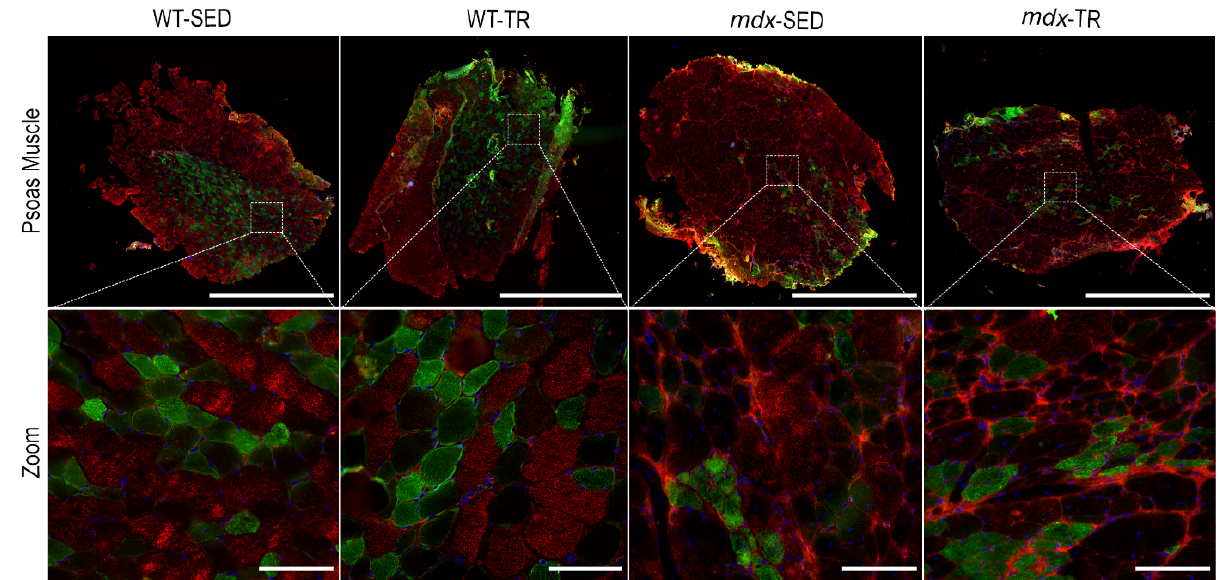
Figure 6. Percentage of type IIA, IIAD/DA, IID, IIDB/BD, and IIB muscle fibers in all groups studied. There was no change in the number of different fiber types. Abbreviations: WT-SED: sedentary wildtype; WT-TR: trained wildtype; mdx -SED: sedentary mdx ; mdx -TR: trained mdx .